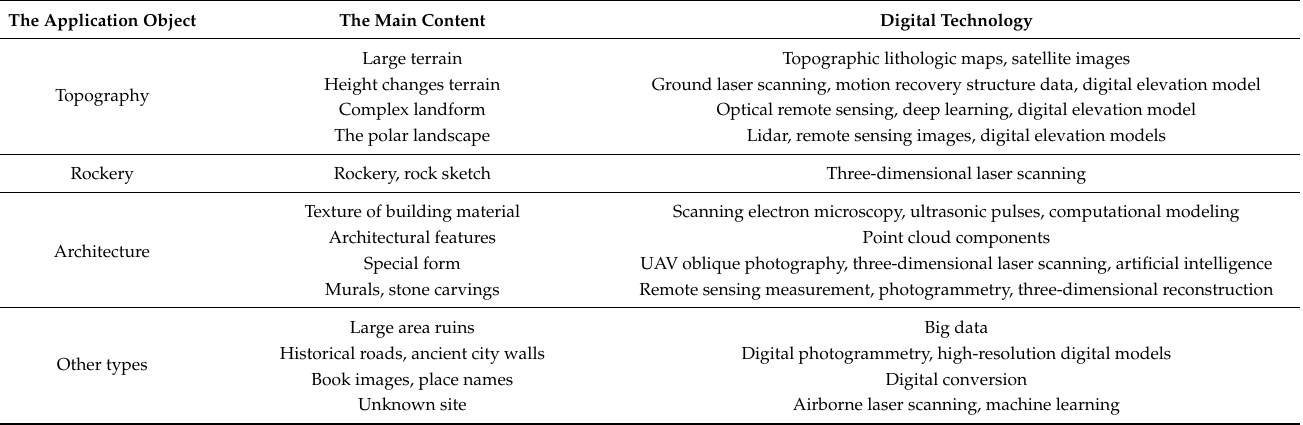
Table 2. Classifications of collection and acquisition